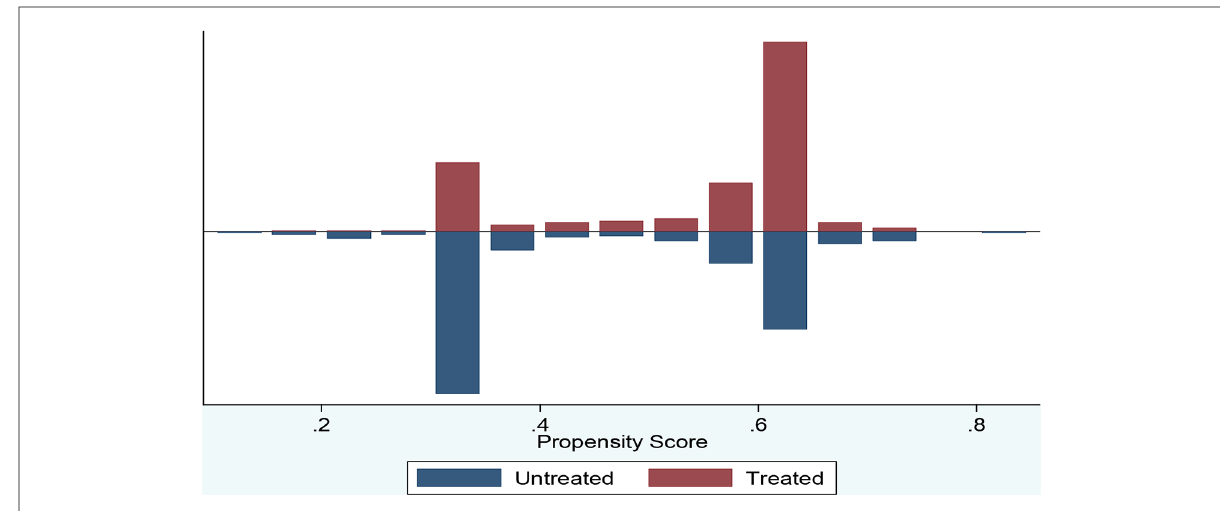
FIGURE 1 Propensity score matching common support graph on mothers in east gojjam zone, NW Ethiopia,